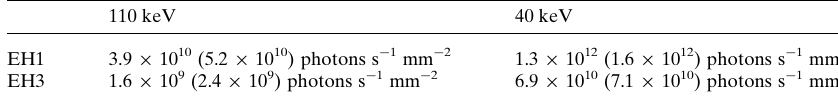
Table 5 Measured (calculated) flux densities at 110 keV and 40 keV.